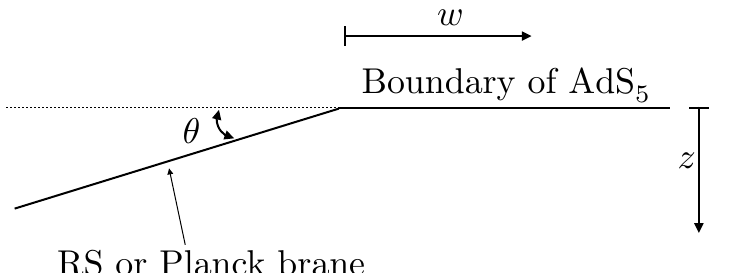
Figure 1: A simple geometry with a RS or a Planck brane, discussed in [ 32 ] . The RS or the Planck brane along lies along the locus z = − w tan θ . The induced geometry on the brane is AdS with length scale (9). The angle θ is fixed by the tension parameter 4 α in the action (1) via the relationship